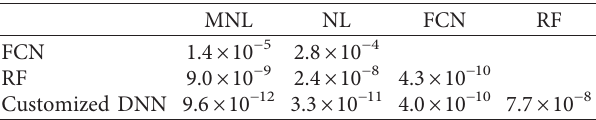
Table 3: P value of welch’s t -test of performances between each model.